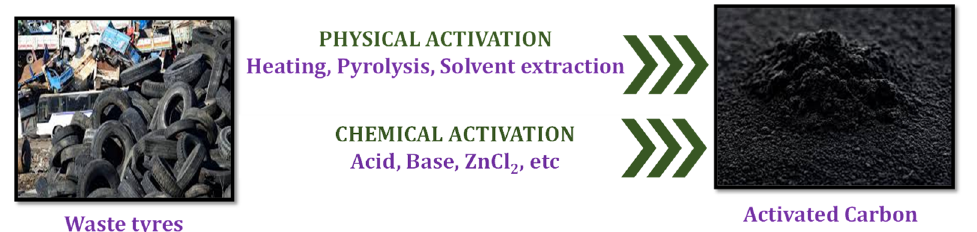
Figure 2. The activation process for the production of AC from waste tyres.